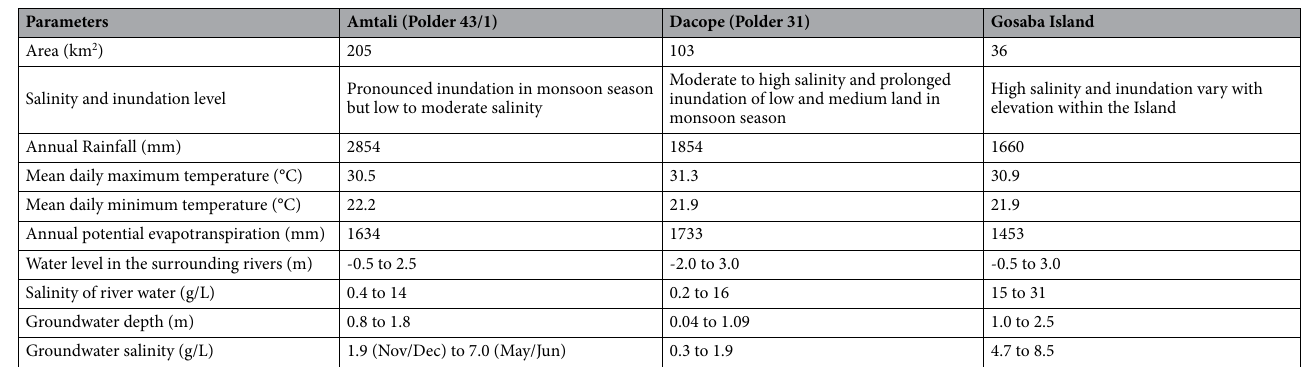
Table 1. Physical and hydro-climate characteristics of the three study